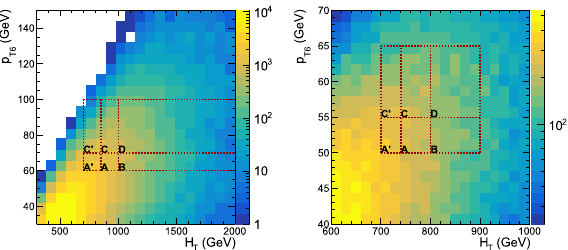
Fig. 5 Distributions of p T 6 versus H T in t ¯ t jj events for the two cases of applications of extended ABCD methods. Note the different scales on the axes. Various control and signal regions are delineated